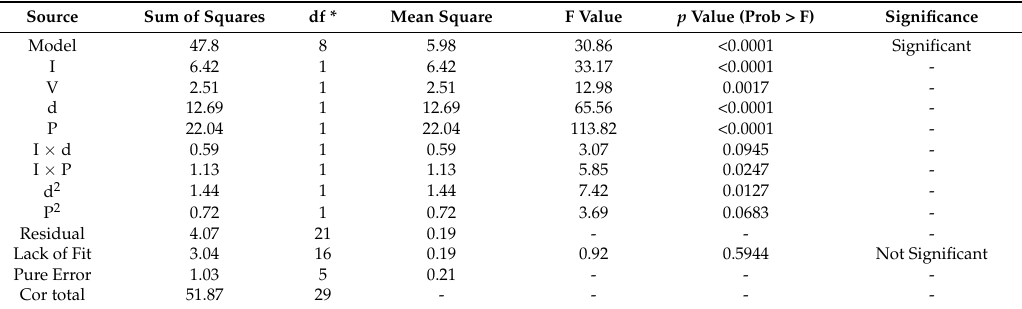
Table 4. Results of analysis of variance (ANOVA) for model of weld